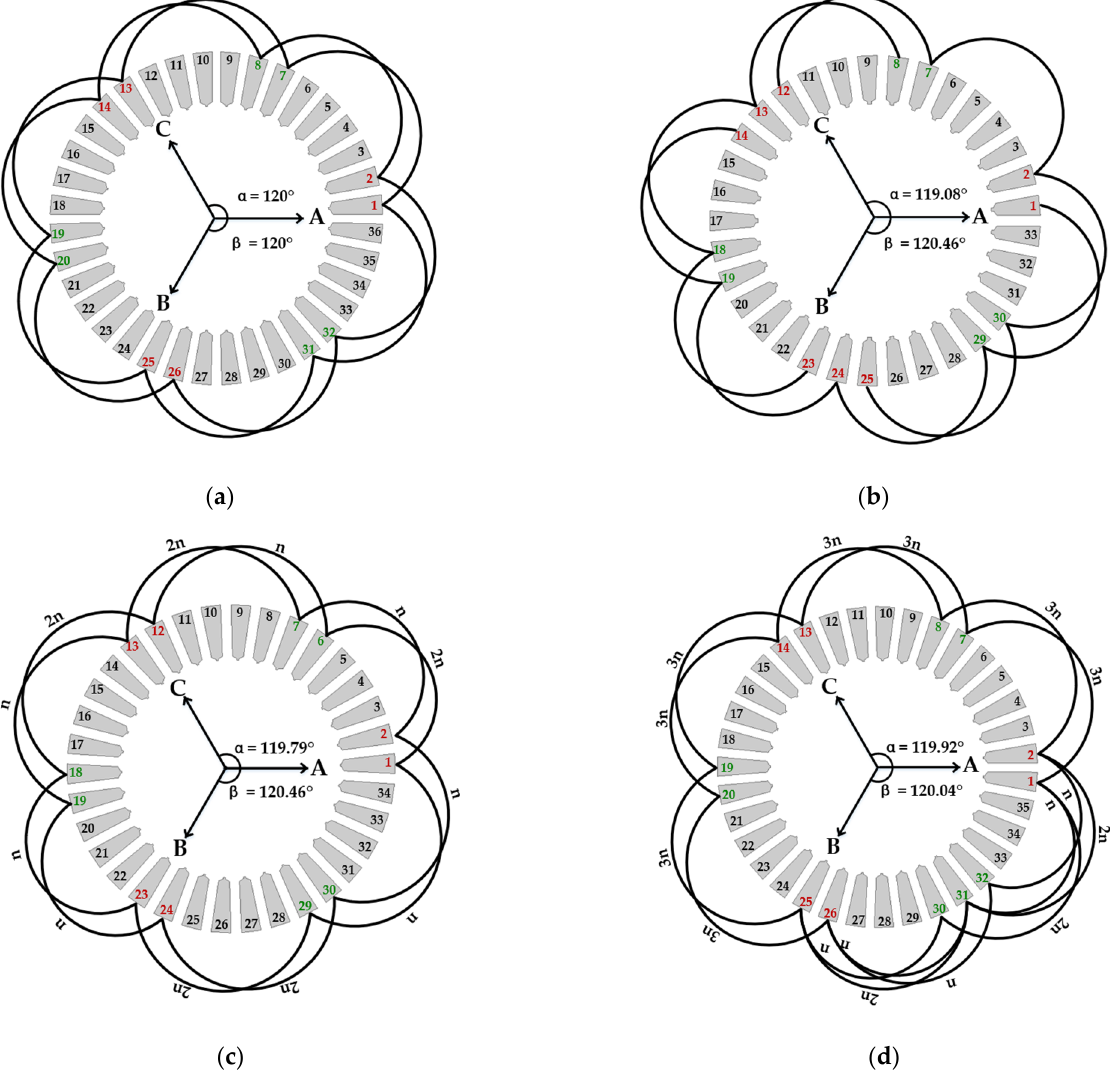
Figure 3. Phase − A coil connection and phase vector diagrams of four motors: ( a ) M 1 : 36 − slot and 6 − pole; ( b ) M 2 : 33 − slot and 6 − pole; ( c ) M 3 : 34 − slot and 6 − pole; ( d ) M 4 : 35 − slot and 6 − pole. Table 12. Winding factors of four motors.